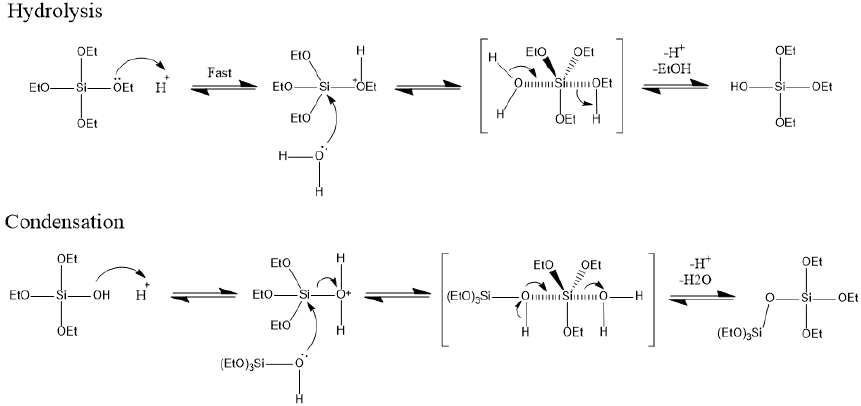
Figure 3. Hydrolysis and condensation reactions of TEOS precursors to form a siloxane polymer chain and subsequent network [28].